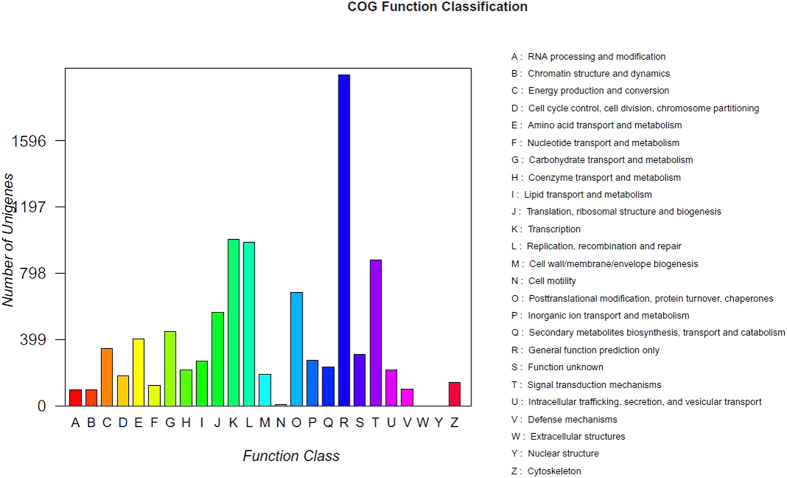
COG functional classification of the S. oleracea transcriptome.